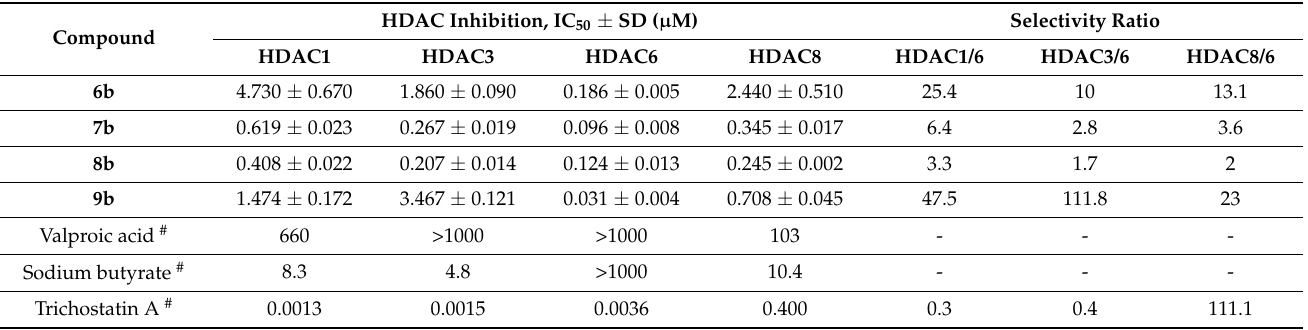
Table 2. Enzymatic in vitro profiles of novel hydroxamic acid 1-benzhydryl piperazine derivatives against HDAC1, HDAC3, HDAC6, and HDAC8